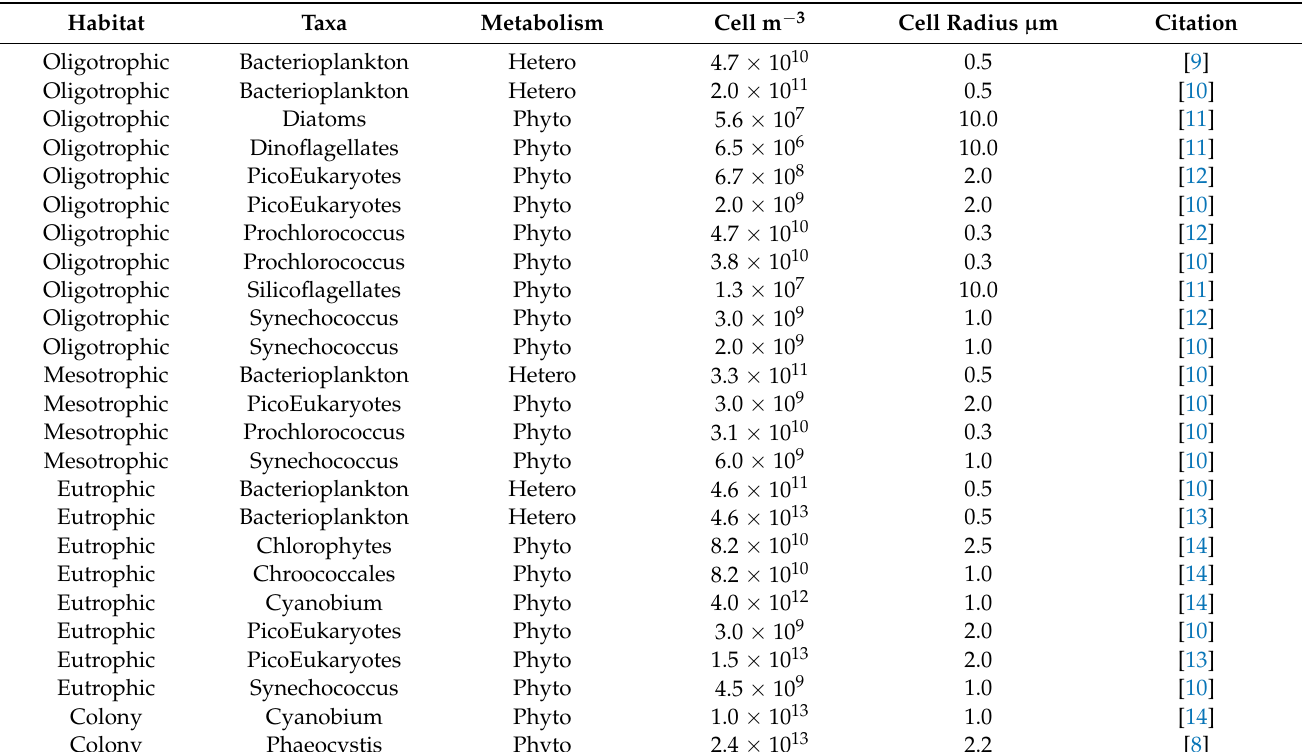
Table 1. Phytoplankton and bacterioplankton cell sizes and representative suspension